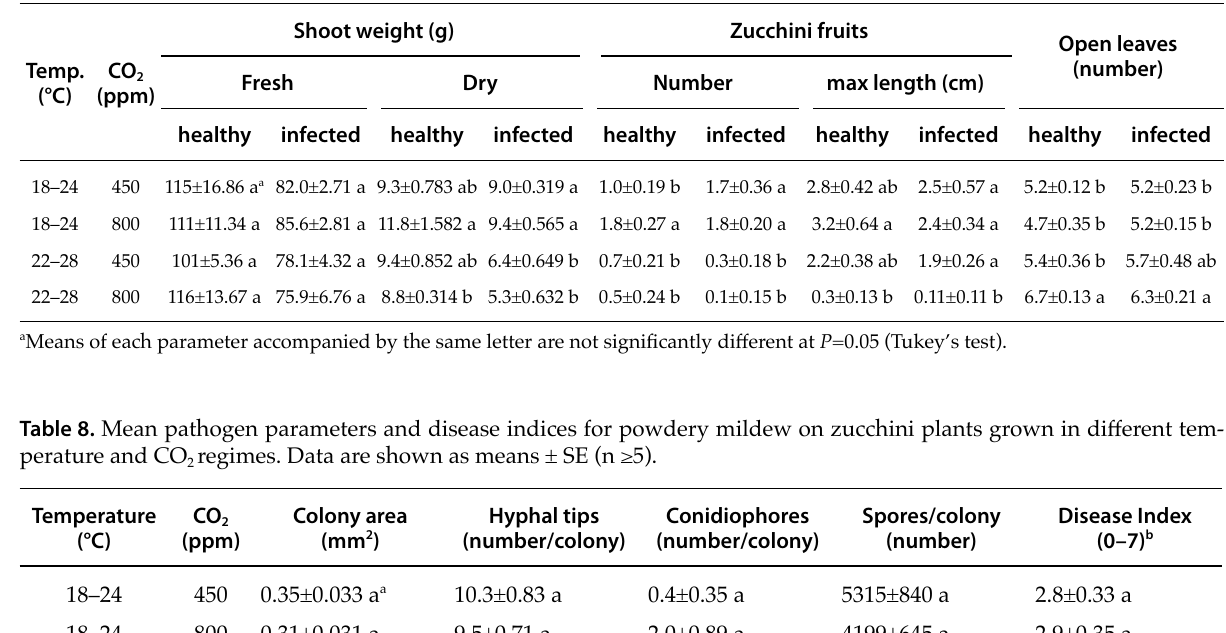
Table 7. Mean fresh and dry weights of plant shoots, numbers and maximum lengths of fruits, and numbers of open leaves at 15 days after inoculation, for zucchini plants grown in different temperature and CO 2 regimes. Data are shown as means ± SE (n ≥5).